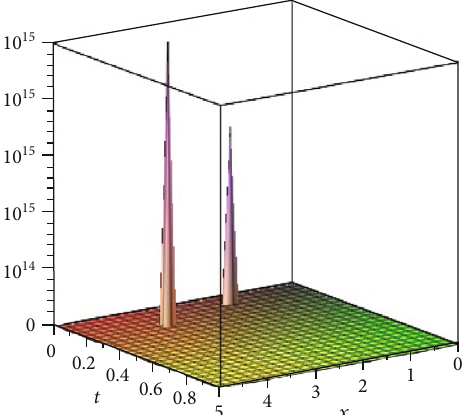
ð x , 0, 0, t Þ of Equation (69). Figure 15: u 1,1